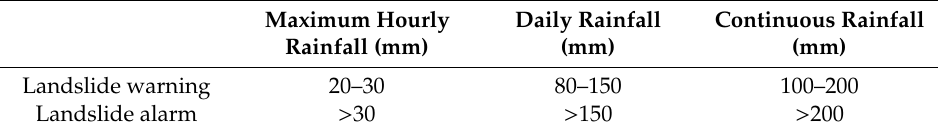
Table 1. Landslide forecasting standard (Korea Forest Service).